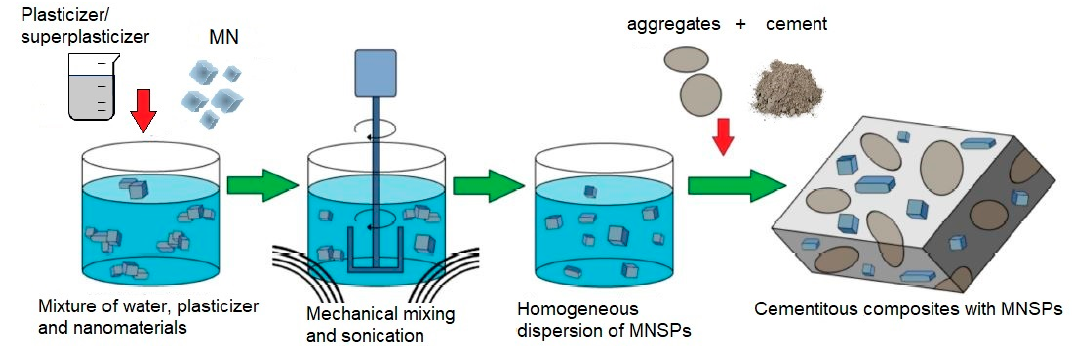
Figure 9. Scheme of the preparation of the cement composite containing magnetite nanoparticles (MN) based on Sikora et al. (Reprinted with permission from [51]).